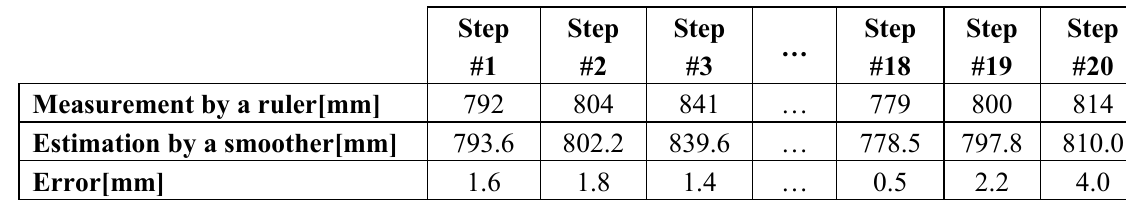
Table 1. Step length estimation (20